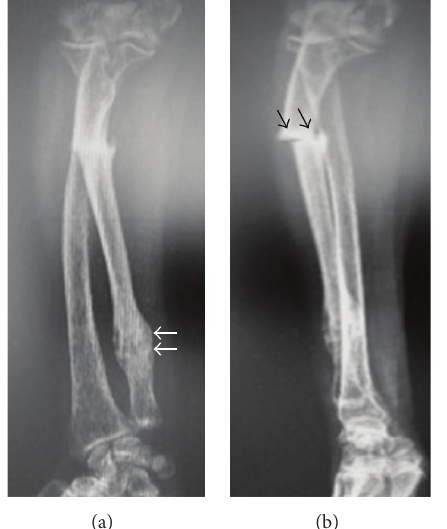
Figure 1: Anteroposterior (a) and lateral radiographs (b) of the patient’s forearm at initial admission. Black arrows show the atypical fracture line. White arrows show the previous healed fracture.